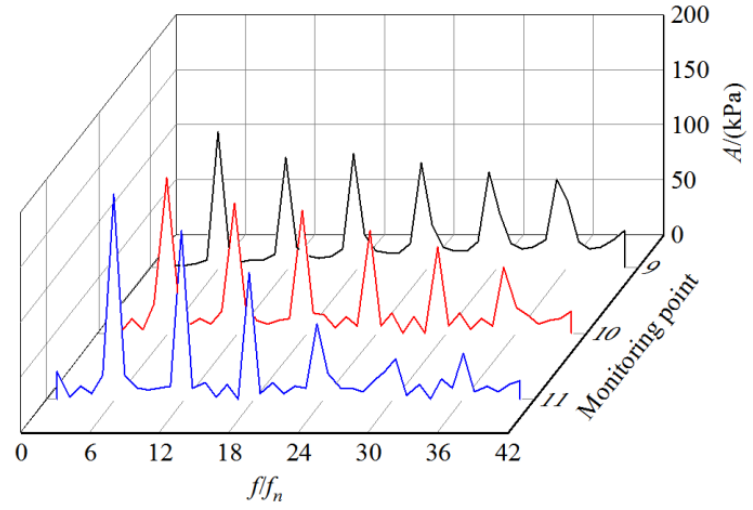
Figure 16. Frequency domain of pressure fluctuation in impeller (curves 9, 10 and 11 represent frequency domain curves at monitoring points 9, 10 and 11 respectively).